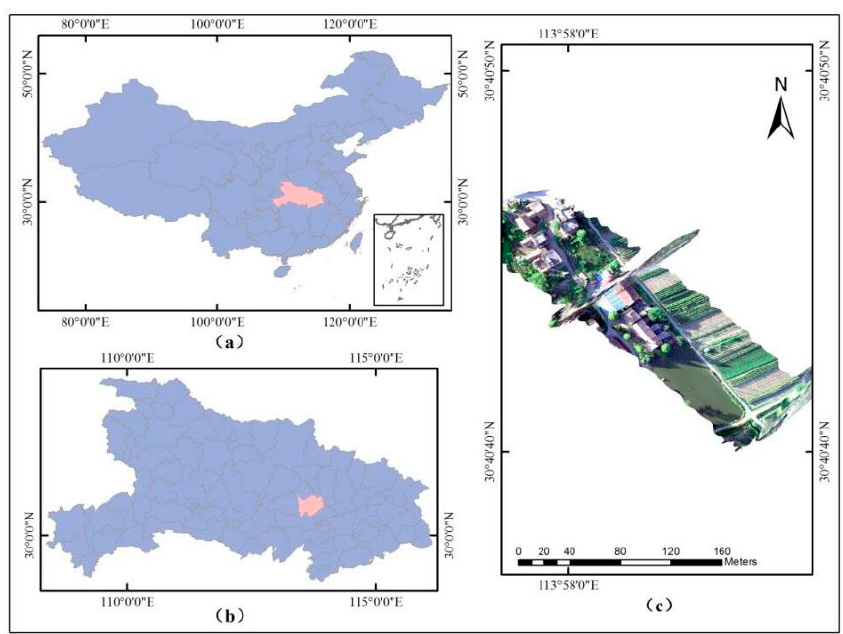
Figure 4. ( a ) The location of Hubei province in China. ( b ) Administrative area map of the city of Hanchuan in Hubei province. ( c ) The study site.